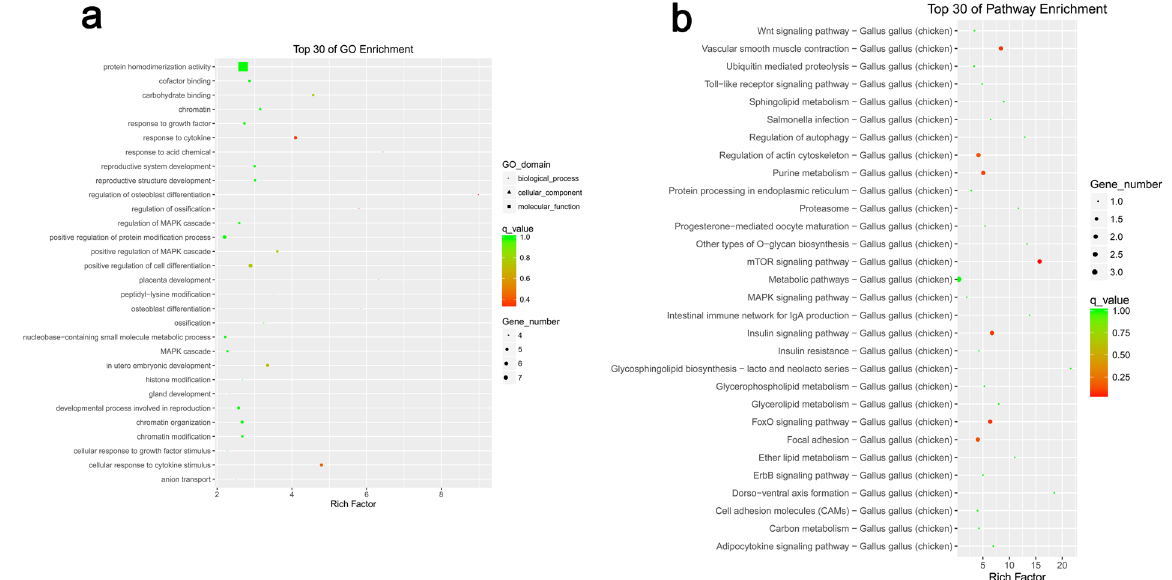
categories: Biological Process, Cellular Component, and Molecular Function. ( b ) The Kyoto Encyclopedia of Genes and Genomes (KEGG) pathway regulated by DE-lncRNAs target genes of long and short-DF